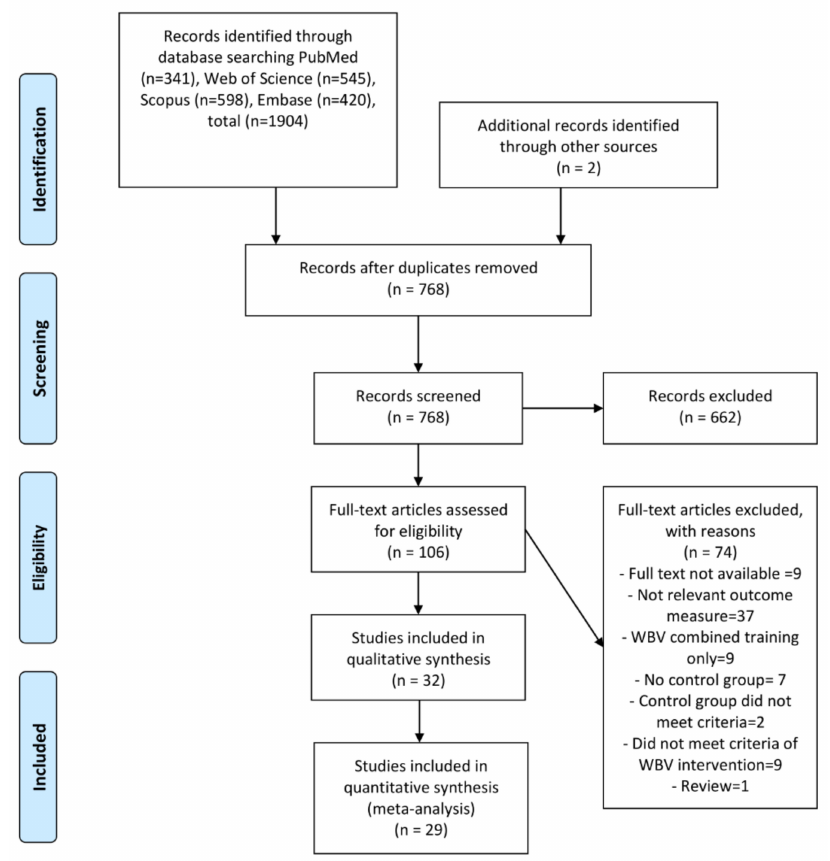
Figure 2. Flow diagram of article selection